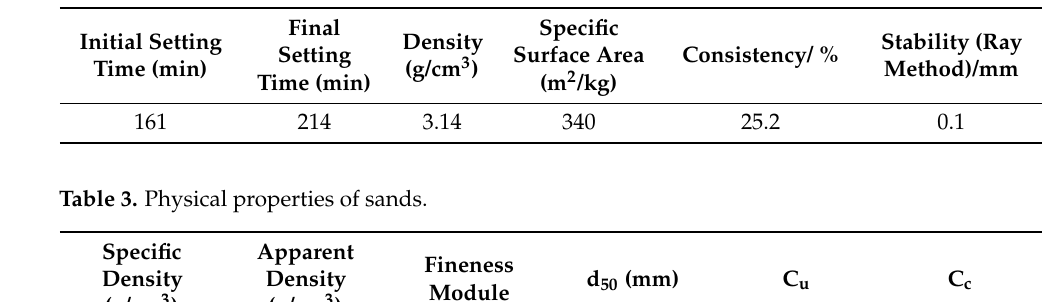
Table 2. Physical properties of OPC.